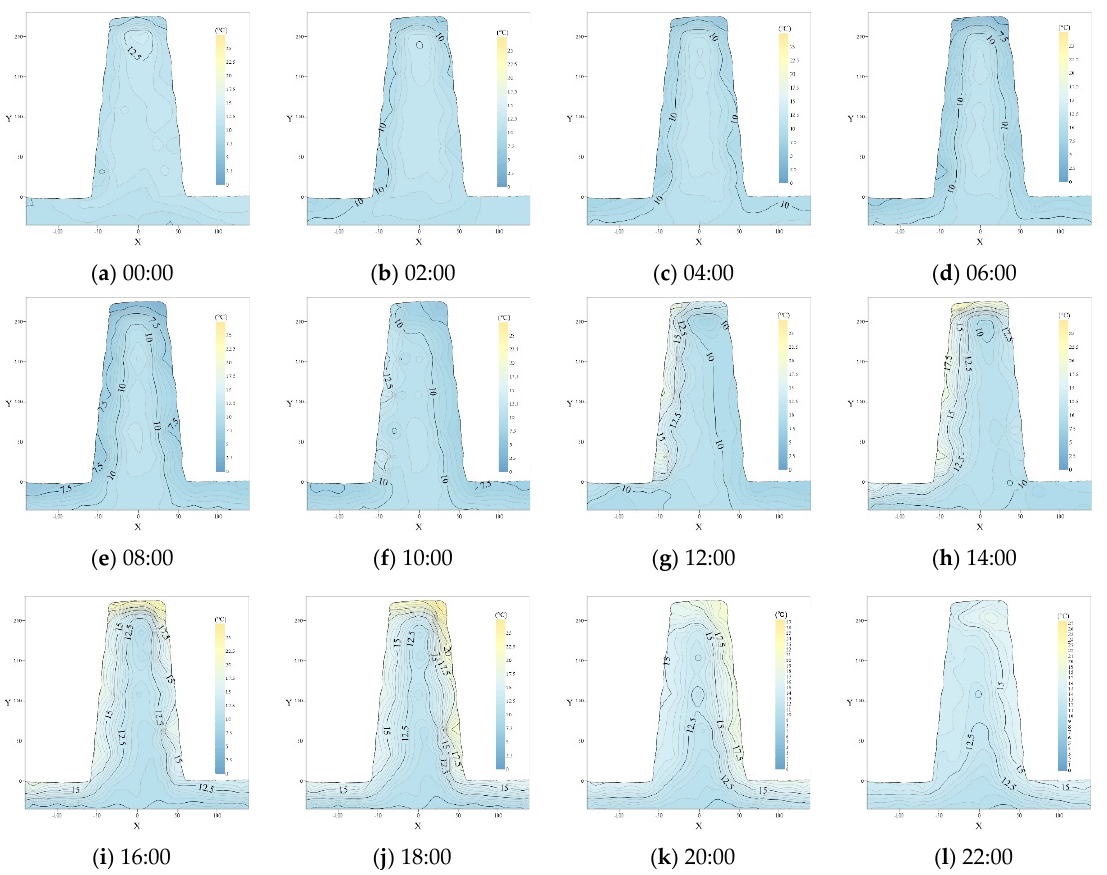
Figure 7. Selection of optimum days for spring illumination.